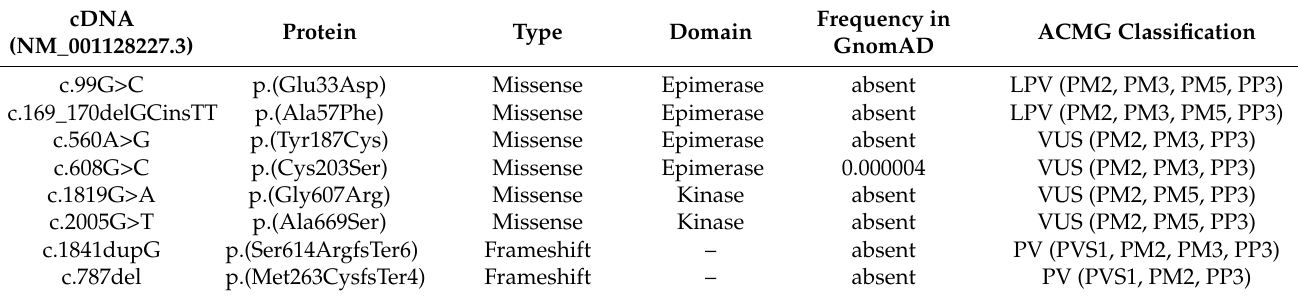
Table 1. Novel variants in patients with GNEM from